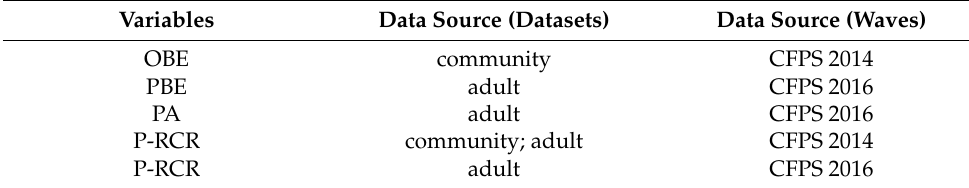
Table 1. Datasets and CFPS waves used in this